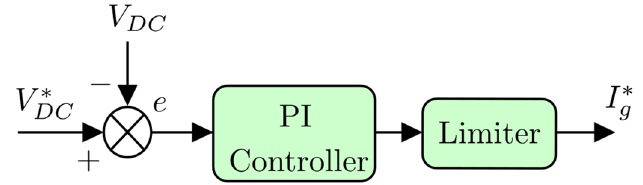
Figure 4. DC link capacitor voltage controller.